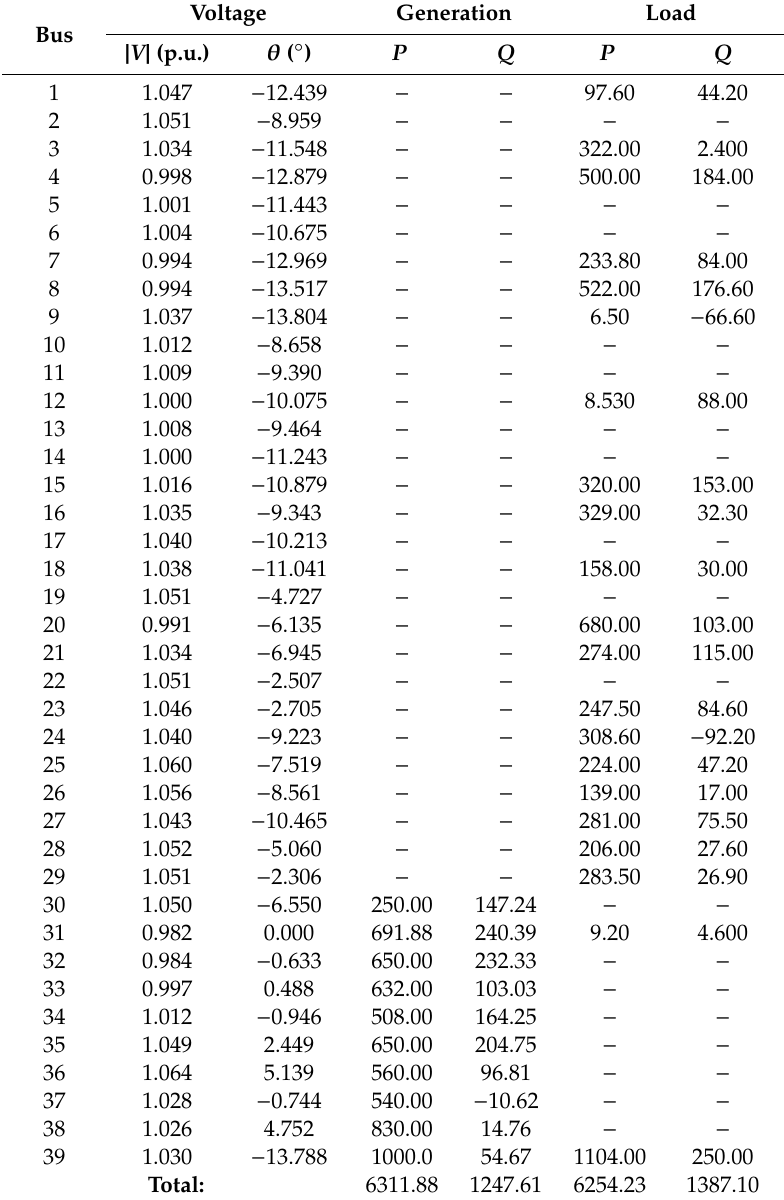
Table A35. Results of Mixed AC / DC PF calculations in Case 7-2. AC bus